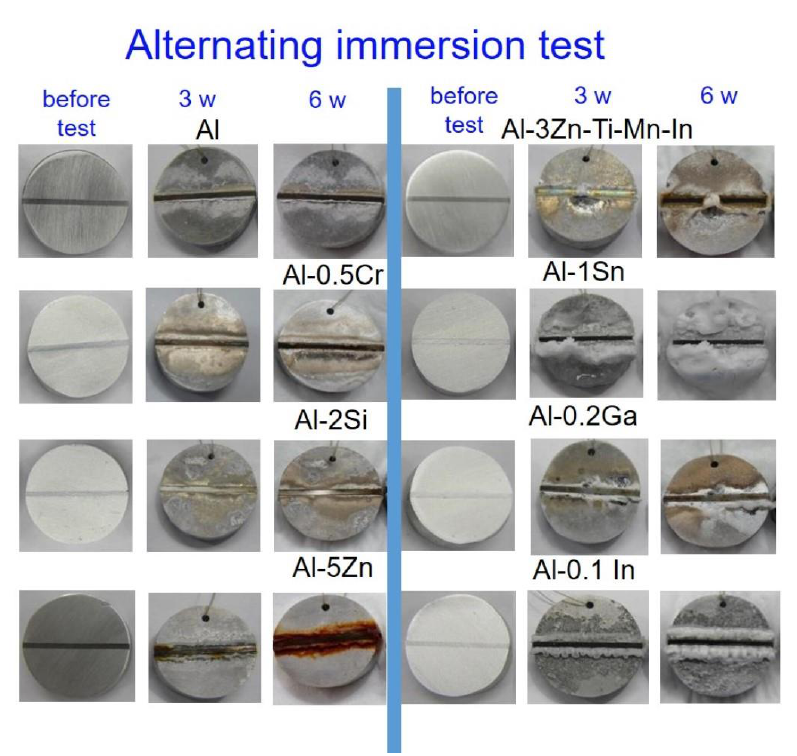
Figure 13. Images of the galvanic-coupled samples of mild-steel-Al-based alloys before testing, after 3 weeks and 6 weeks exposure in alternating immersion test.